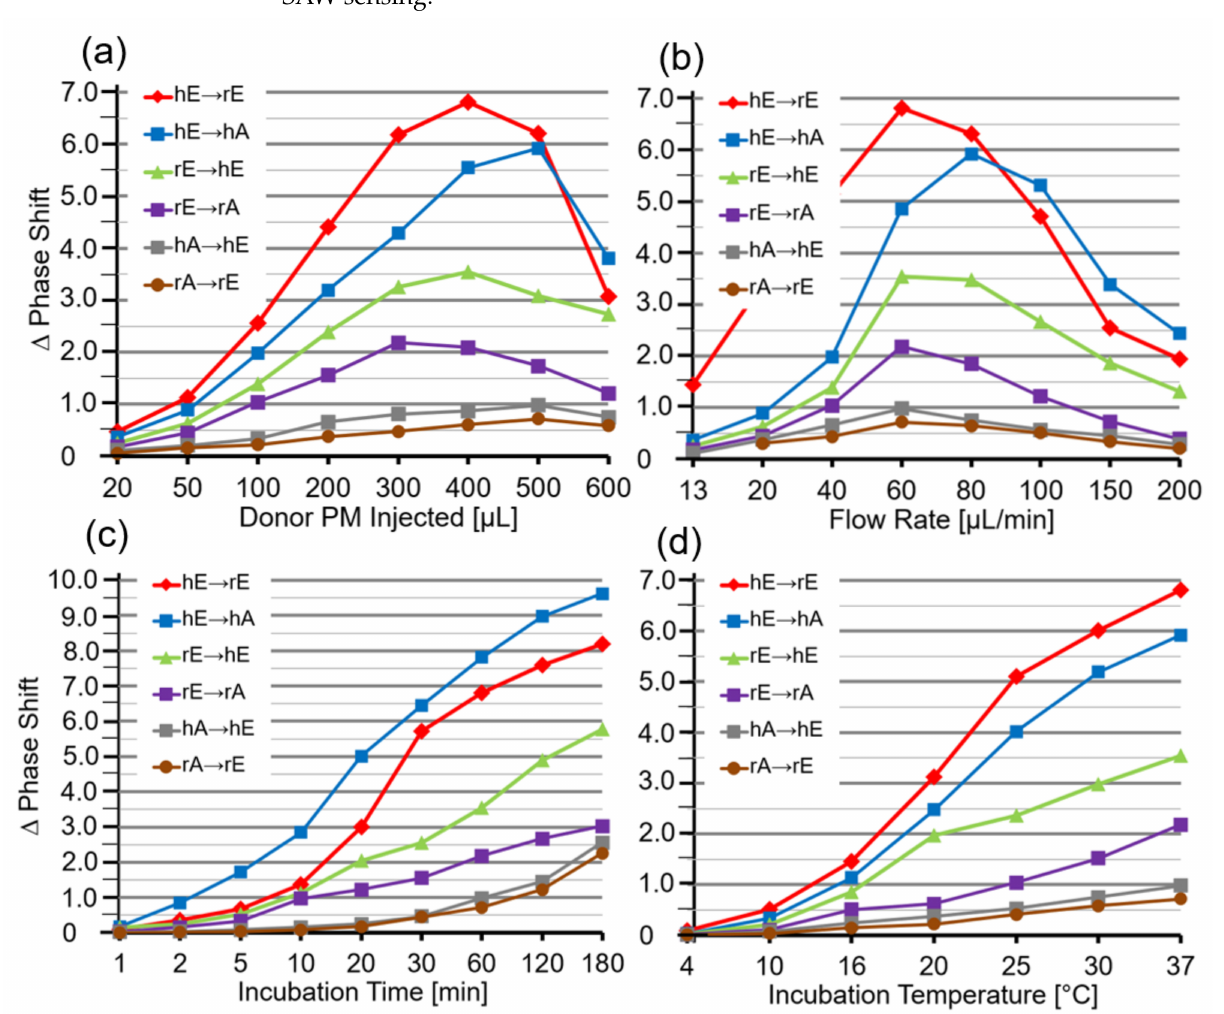
Figure 4. Optimization of chip-based sensing system for transfer of GPI-APs and membrane proteins from donor to acceptor PM. Dependence of transfer efficacy on the amount of donor PM ( a ), flow rate during donor PM injection ( b ), length of transfer period ( c ), temperature during transfer ( d ). The experiment was performed as described for Figure 3 with injection of donor PM at 800 s, and start of incubation of the donor–acceptor PM combinations indicated at 1200 s in the absence or presence of PI-PLC (in the absence of α -toxin) ( a ) with increasing volumes of the donor PM at a flow rate of 60 µ L/min for 60 min at 37 ◦ C, ( b ) at increasing flow rates with 400 µ L of donor PM for 60 min at 37 ◦ C, ( c ) for increasing incubation periods with 400 µ L of donor PM at flow rate 0 at 37 ◦ C and ( d ) at increasing temperatures with 400 µ L of donor PM at a flow rate of 60 µ L/min for 60 min. ∆ phase shifts as measure for GPI-AP transfer are calculated as described for Figure 3. The experiments were repeated two times with similar results. Mean values are given for each donor–acceptor PM